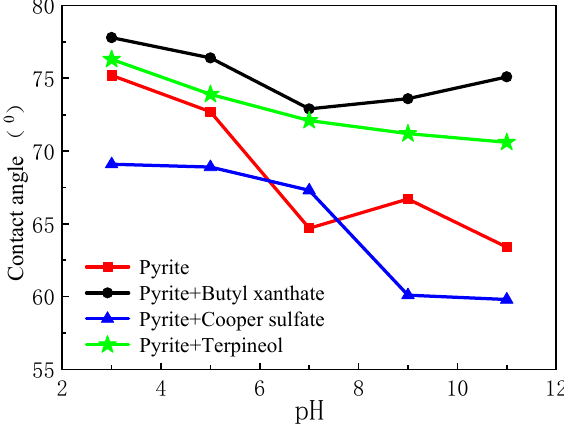
Figure 6. The contact angle of pyrite as a function of pH.